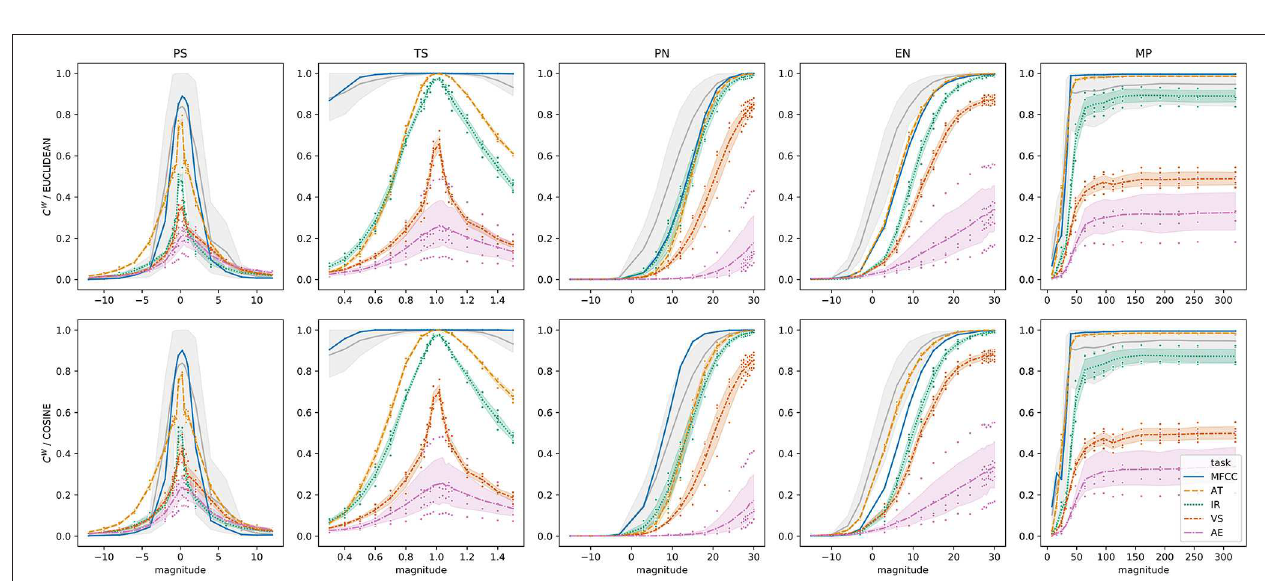
FIGURE 6 | Within-space consistency by transformation on the audio space A . Each curve indicates the within-space consistency C W .